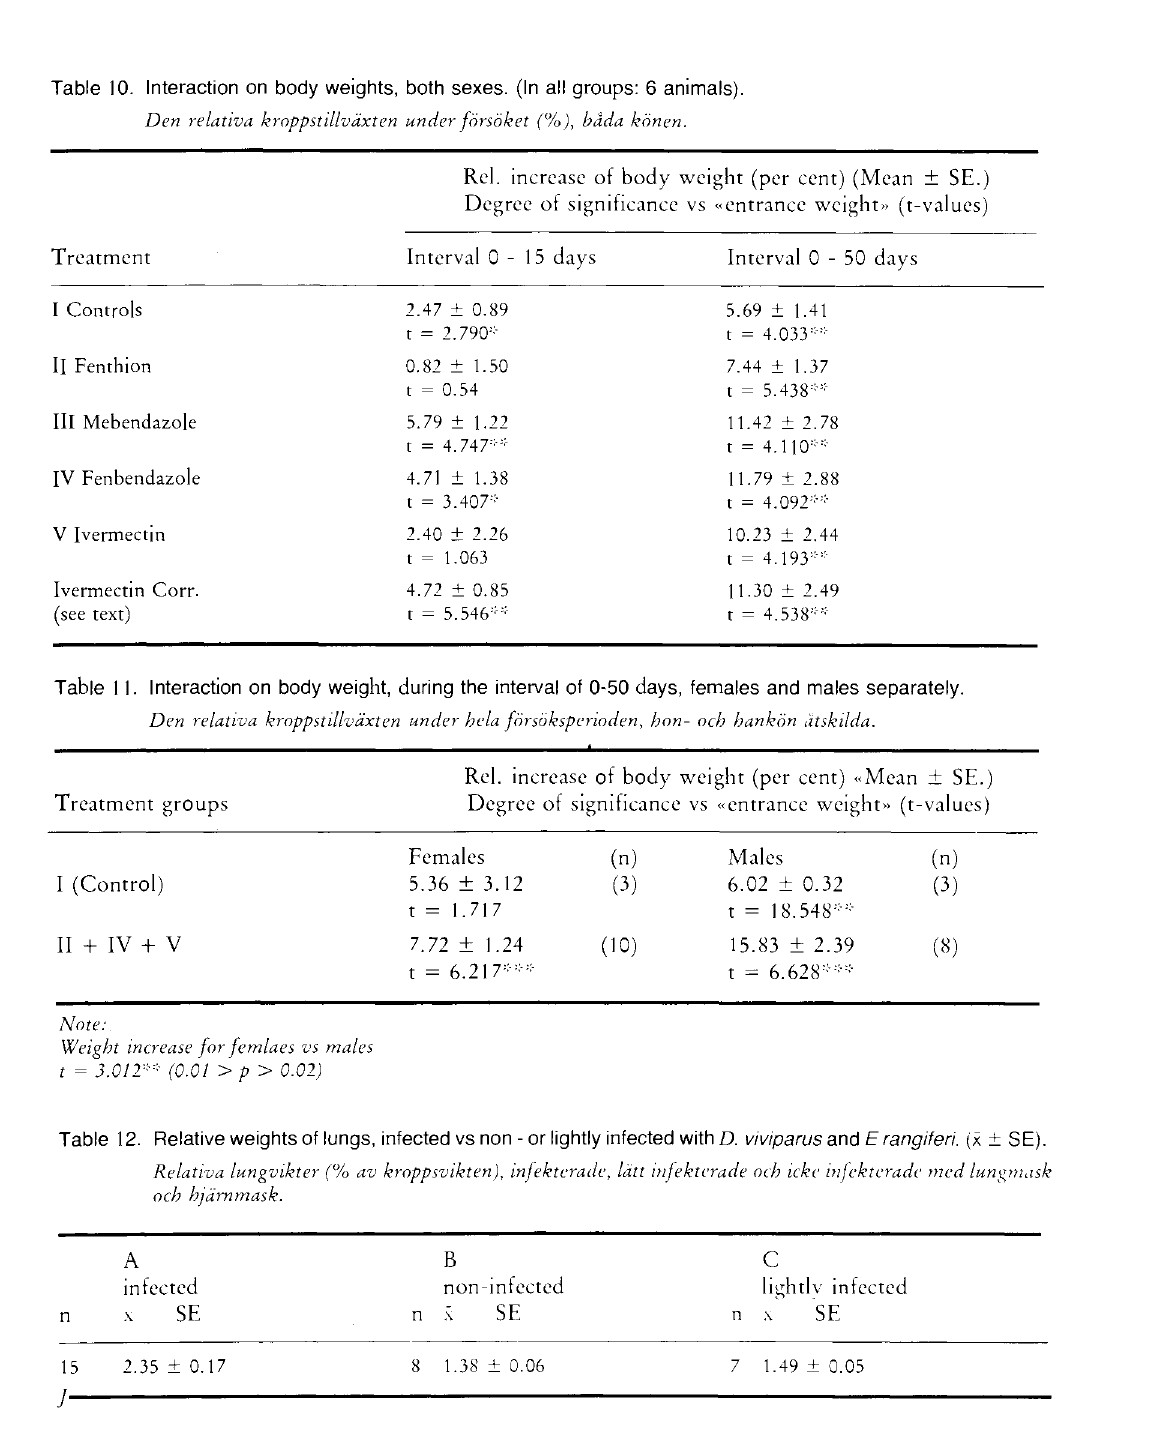
Table 12. Relative weights of lungs, infected vs non - or lightly infected with D. viviparus and E rangifeh. (x ±